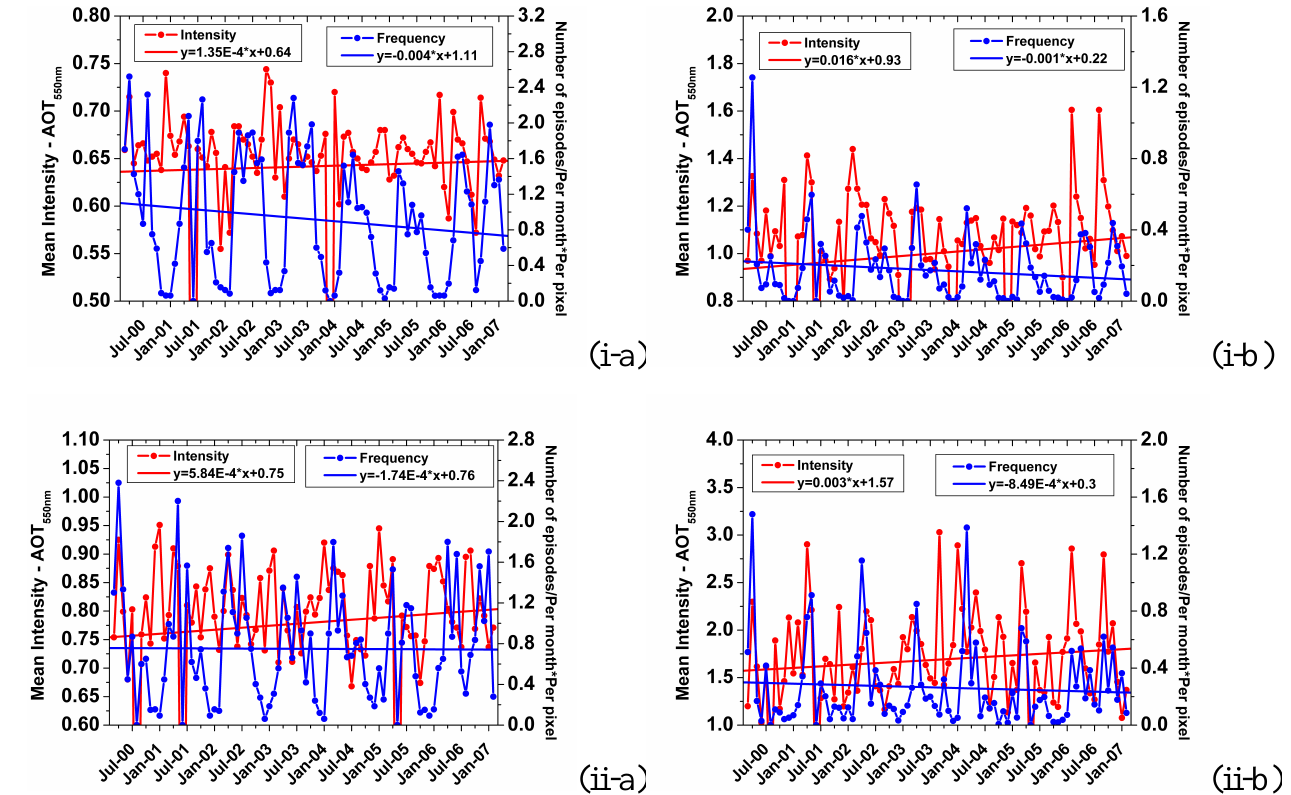
Figure 7. Inter-annual variation and tendencies of mean intensity (red curves) and frequency (blue curves) of (a) strong, and (b) extreme aerosol episodes over (i) land areas and (ii) sea areas in the Mediterranean basin over the period 2000-2007.